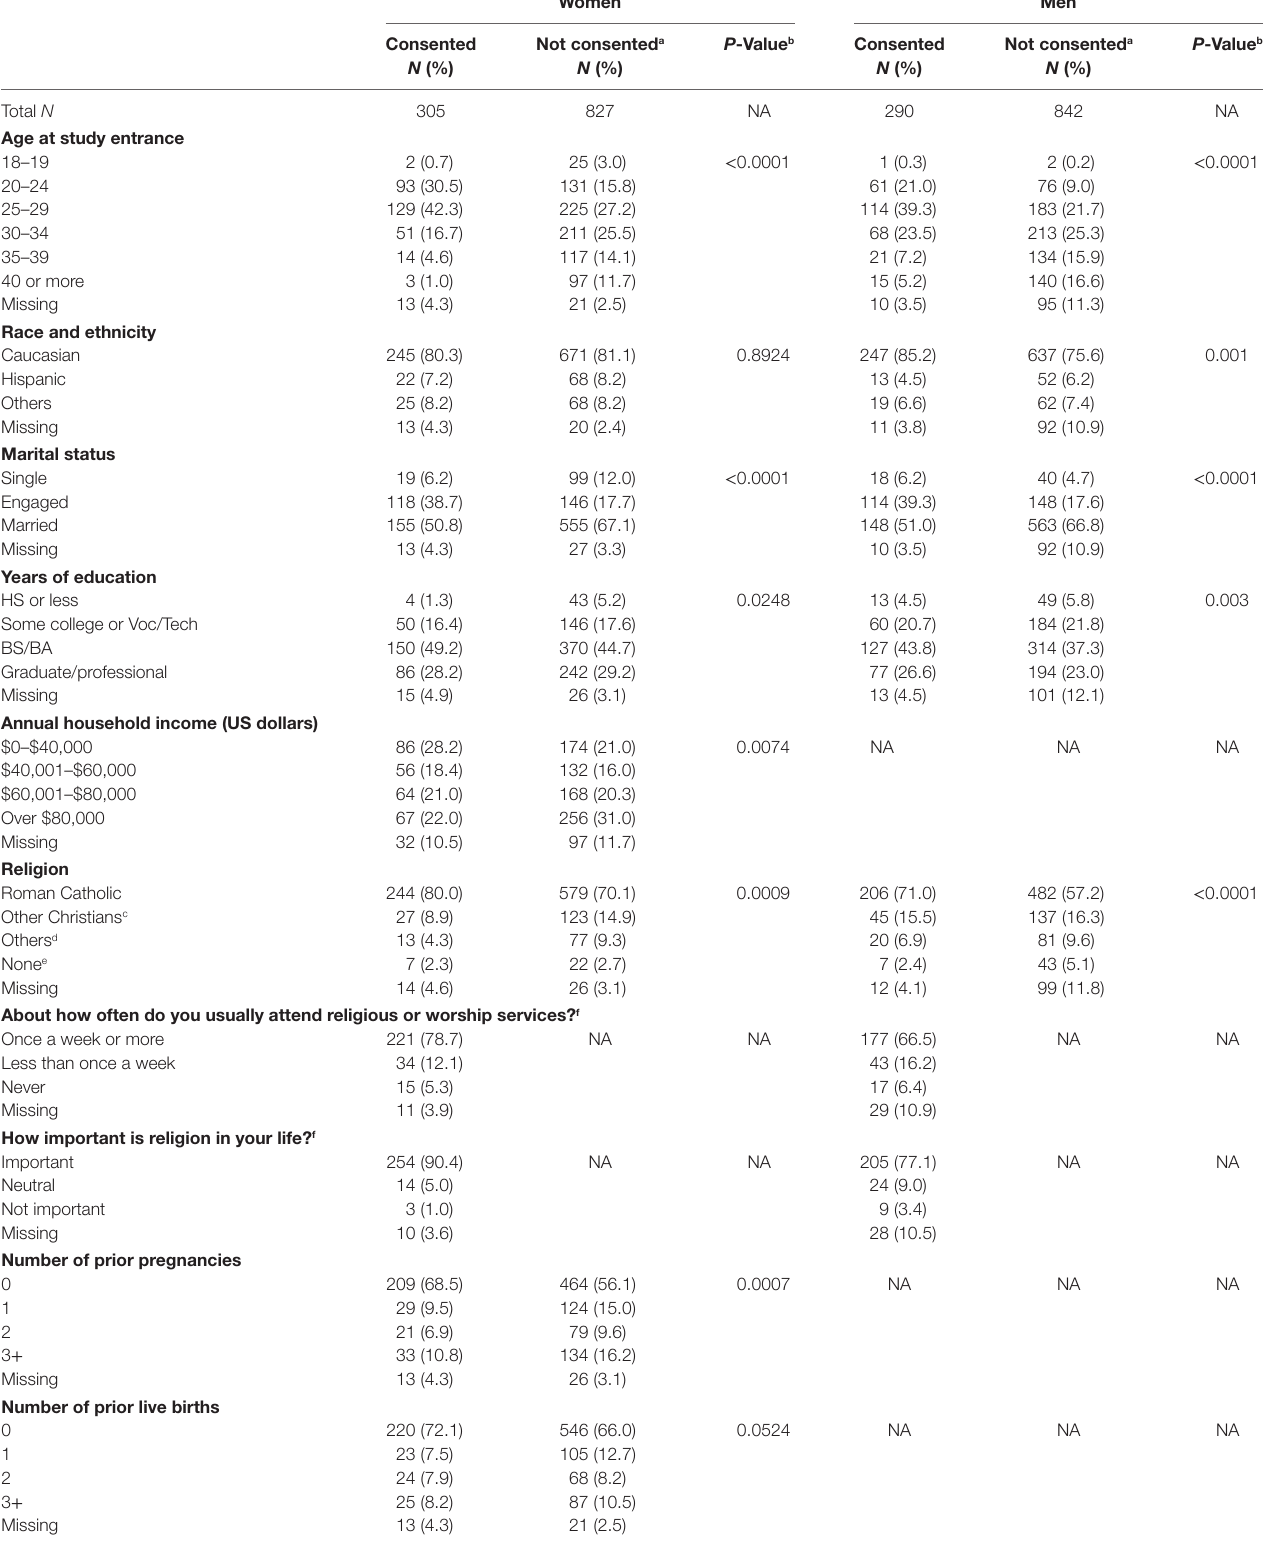
TaBle 2 | Demographic and reproductive characteristics of women and men consented and not consented for the CEIBA